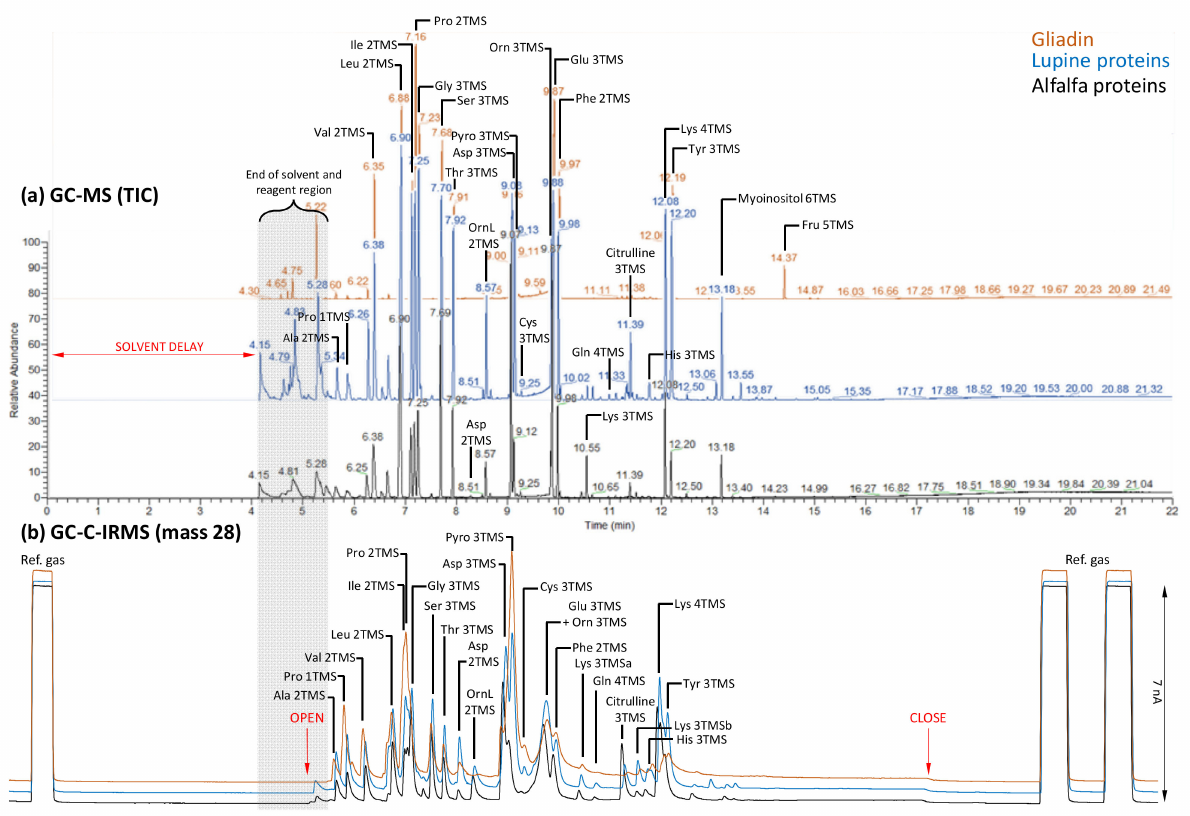
Figure 1. GC-MS (total ion current, TIC) ( a ) and IRMS (mass-28) ( b ) traces of protein hydrolysis samples . This figure shows typical traces for the three sample types, graphically separated by an offset ( y -axis) to facilitate reading. Peaks are labelled with names showing the number of TMS (trimethylsilyl) groups. Note the presence of sugar impurities in samples (myoinositol, fructose). The region corresponding the end of the solvent (and reagents) elution time window is shaded in grey (left). In ( b ), time has been readjusted (thanks to alkanes) to show the coincidence between TIC and mass-28 traces (peaks) and, thus, correct for the longer retention time in GC-C-IRMS analyses due to the preparative line. Letters “a” and “b” for Lys 3TMS refer to two possible forms of Lys 3TMS (one or two N atoms carrying TMS groups). “Pyro” and “OrnL” stand for pyroglutamate (Figure 3) and ornithine lactam (Figure 4), respectively. The flow to IRMS (switch from waste to analysis and back to waste) is shown with red arrows “open” and “close”. The amplitude of the reference signal is shown in current units nA (10 − 9 A). To facilitate reading, a magnified version of this figure is provided in Supplementary